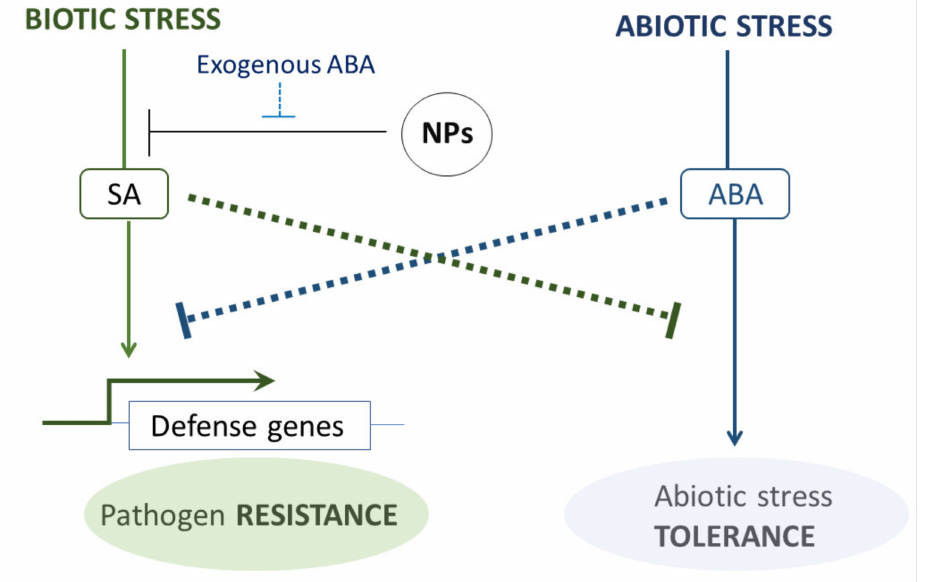
Figure 6. Early effects of NP exposure on stress-signaling pathways, as inferred from transcriptome analysis and phenotypes observed by Garc í a et al. [34]. NPs interfere with biotic stress pathways by transcriptional inhibition of pathogen-sensing and SAR-signaling genes. Exogenous addition of ABA can increase the expression of affected genes and remediate some transcriptomic effects upon NP